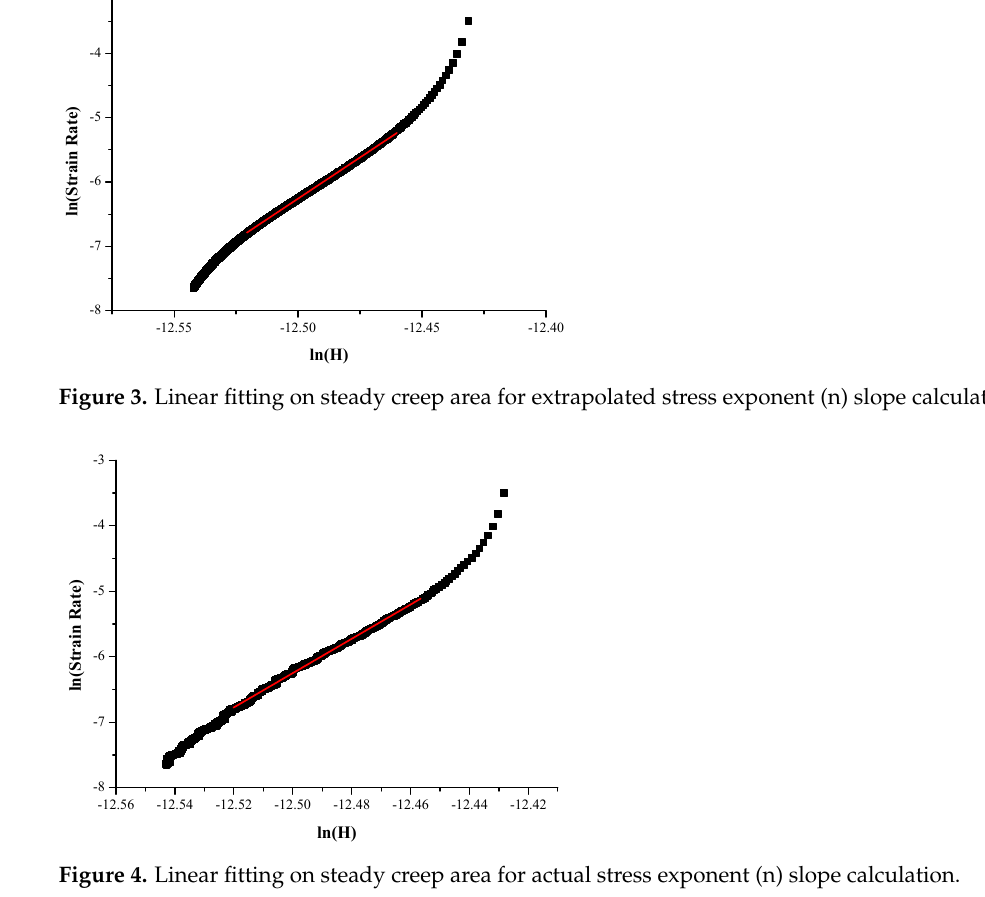
Figure 2. Power law fitting on actual creep depth versus time curve.